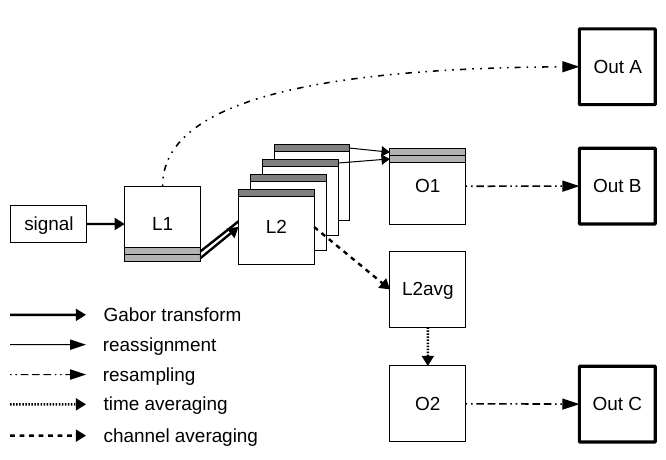
Figure 2. Diagram explaining the naming of the GS building blocks of the Python implementation in